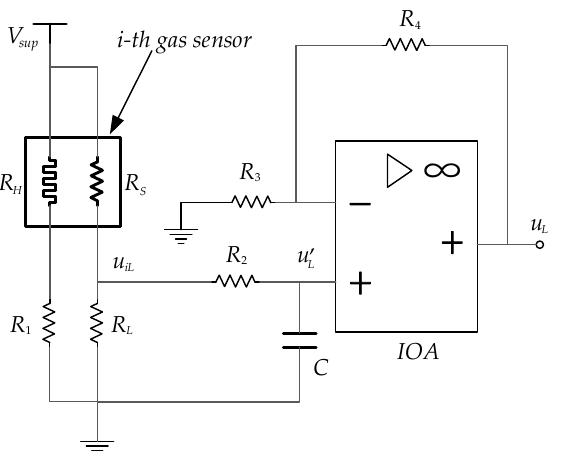
Figure 6. The front-end circuit for sampling the i -th sensor’s sensing voltage. IOA is an integrated operation amplifier. V sup is the power supply voltage of the sensors.